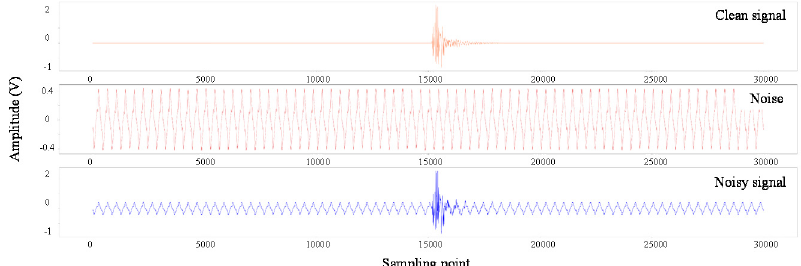
Figure 8. The noisy signal was formed by superimposing the clean signal with noise. Clean signal and noise were all recorded by the same microseismic monitoring acquisition station in Micang Mountain tunnel (China).